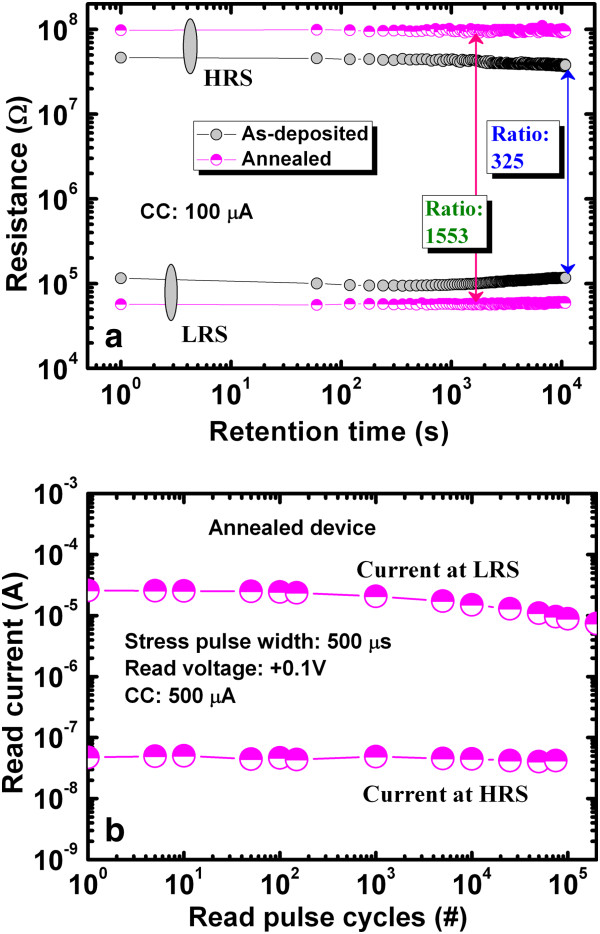
Data retention characteristics and good pulse read endurance. (a) Data retention characteristics of the IrOx/GeOx/W devices. The resistance ratio is larger for the PMA devices than that of the as-deposited one after 104 s. (b) Good pulse read endurance of >105 cycles is obtained for the PMA devices.